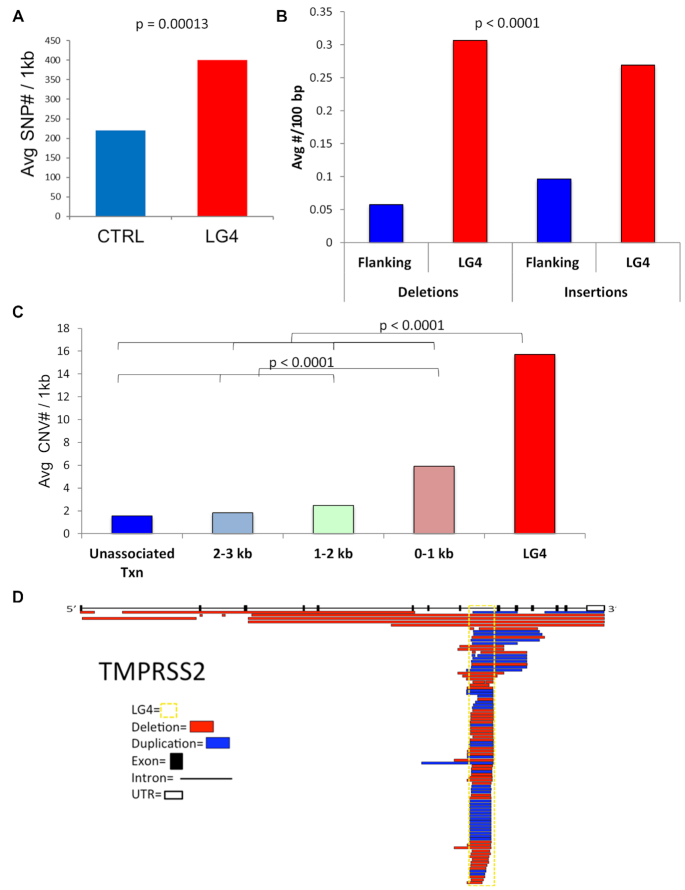
LG4s are associated with increased small and large-scale genome variation. (A) Entries from the dbSNP database for LG4s and size matched control regions. (B) Entries from the dbSNP database for LG4 and intronic regions directly surrounding LG4 (flanking). (C) CNV sizes from dbVAR and the average number of breakpoints/kb (y-axis) was calculated for each transcribed LG4, in 1kb increments away from LG4, and the rest of the transcript not directly associated with LG4 (Unassociated TXN). (D) Schematic diagram of the location and size of copy-number variants with respect to the predominant TMPRSS2 transcript. Introns, exons and UTRs denoted by lines, solid boxes, or open boxes, respectively. The yellow dashed box highlights the location of the TMPRSS2 LG4 and individual duplications (blue boxes) and deletions (red boxes) are shown.